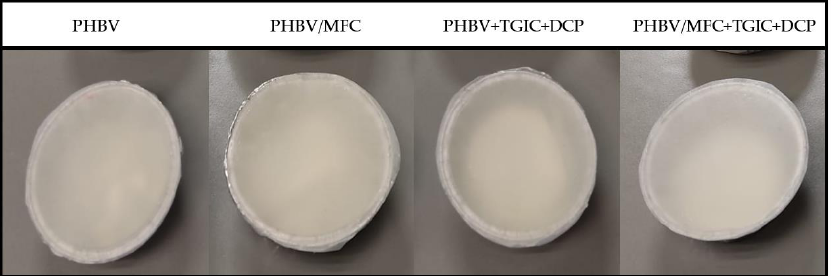
Figure 5. Images of the sunflower oil samples packaged in trays with the green composite lid films of poly(3-hydroxybutyrate- co -3-hydroxyvalerate) (PHBV) with microfibrillated cellulose (MFC) and compatibilized with triglycidyl isocyanurate (TGIC) and dicumyl peroxide (DCP).